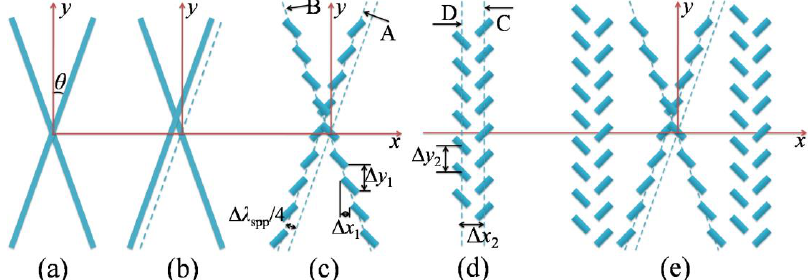
Figure 1. The design flow chart of the proposed plasmonic device. ( a ) A fork-type grating structure. ( b , c ) Discrete fork grating into distributed subwavelength slit arrays, to constitute an X-shaped device. ( d ) An I-shaped device consisting of double columns of subwavelength slits with the function of unidirectional launching of SPP waves. ( e ) The designed IXI shaped plasmonic device.